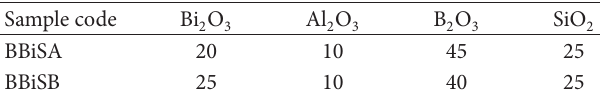
T 1: Chemical composition (mole fraction) of the glass samples used in this